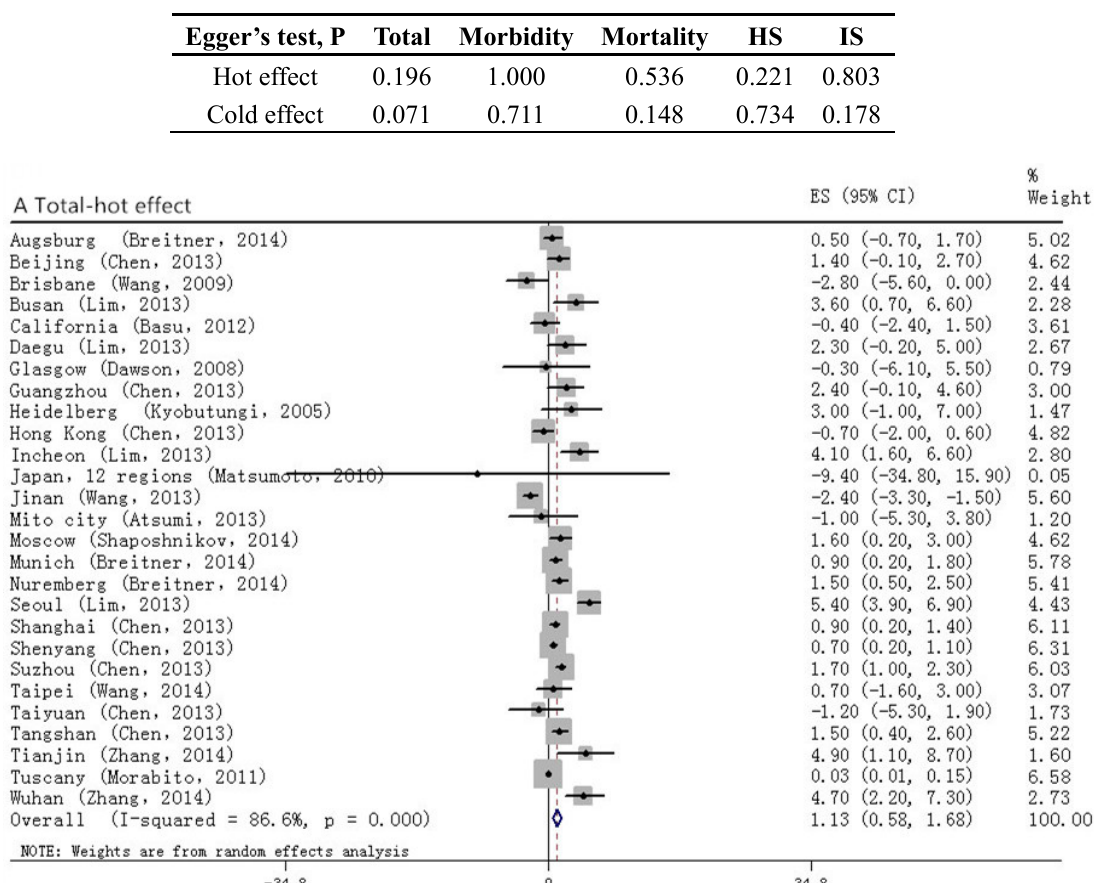
Table 2. p values for Egger’s test in overall